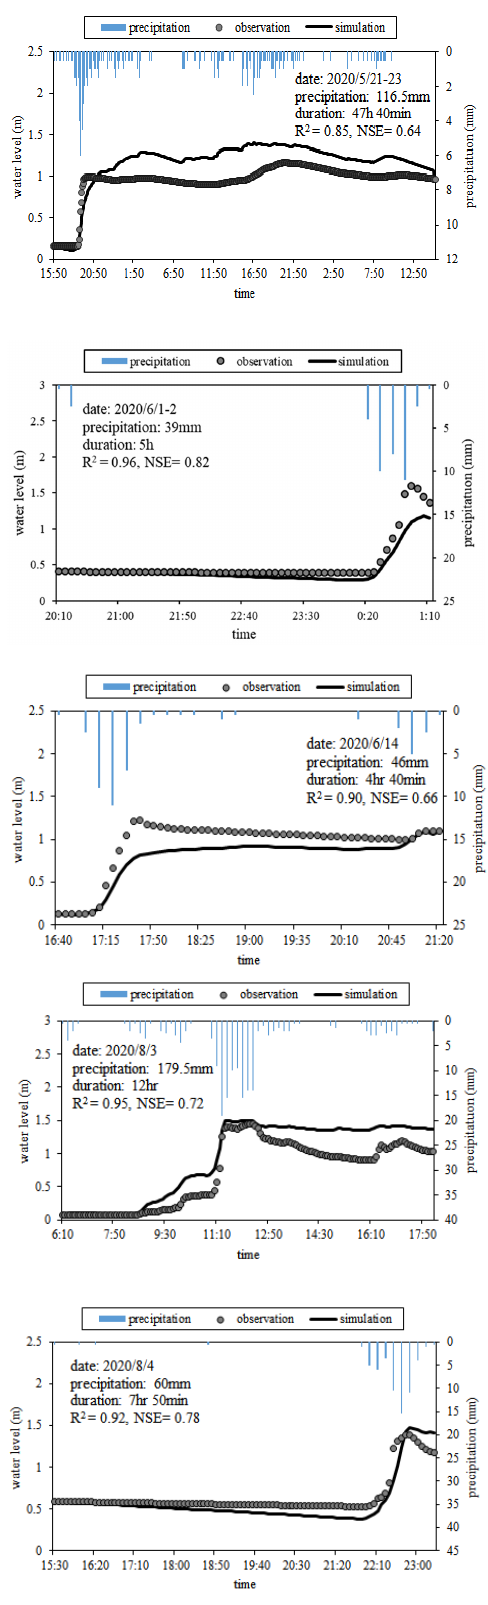
Figure 7. Five different rainfall events used for model calibration and verification at the raingarden site. Table 3. The model parameters of the LID facilities used in the SWMM.